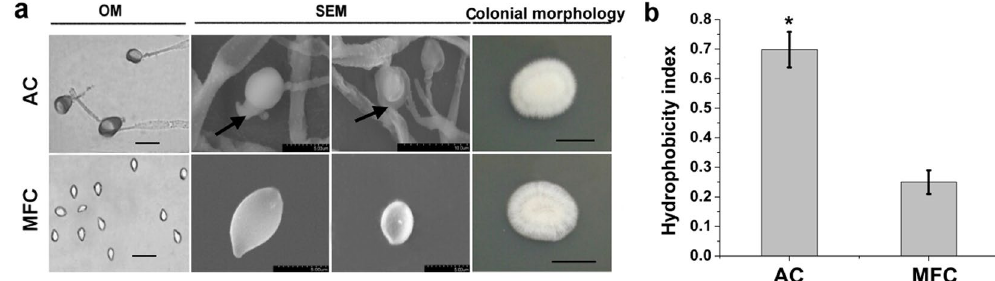
Figure 1. Morphological observing and hydrophobic testing of two spores from Hirsutella satumaensis . ( a ) Using LM and SEM image of AC and MFC respectively, the mucilage on AC can be clearly observed no matter under LM or SEM, indicating with the black arrows in the figure. The right shows the colonial morphology of two spores on PDA incubated for 14 days. LM bar = 10 μ m, SEM scale bars are in micrographs, colony bar = 1 cm. ( b ) Cell surface hydrophobicity of the two spores assessed by MATH assay. AC is clearly hydrophobic (0.698 ± 0.06) and MFC become hydrophilic removing the mucilage (0.25 ± 0.04). Statistical analysis was performed using a one-way ANOVA. Error bars are standard deviations of three trials and panels are representative of at least 2 independent experiments, * p <